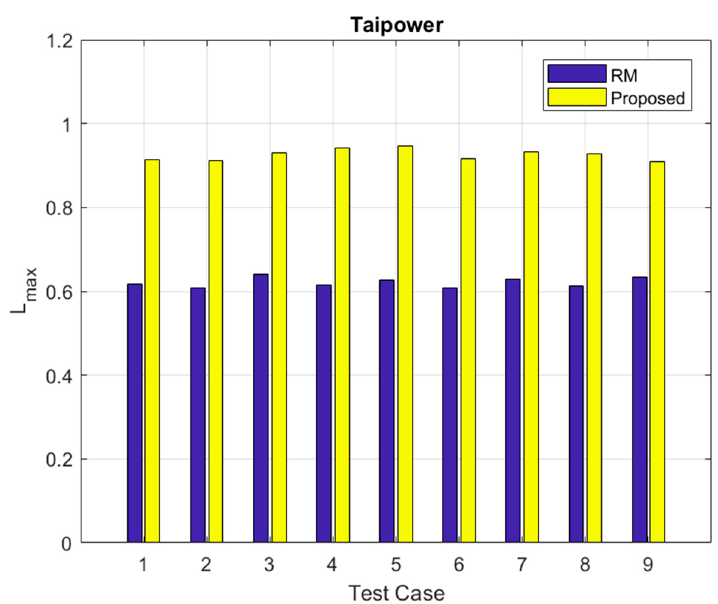
Figure 12. Comparisons for system load at voltage collapse point under different test cases in Taipower system. A higher max L indicates a better performance.